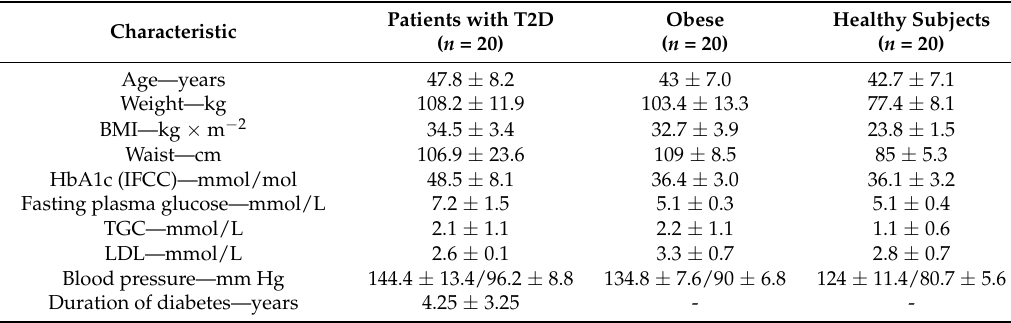
Figure 1. Enrollment of the participants and completion of the study. Table 1. Characteristics of the study population. Data are means ± standard deviation (SD).